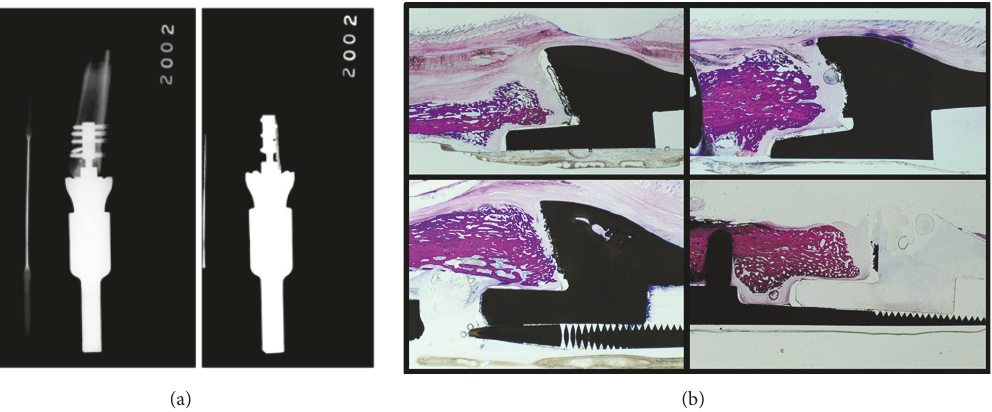
Figure 7: (a) This figure shows radiographs of the implant in Sheep 2B. (b) Histological analysis of Sheep 2B demonstrating tenuous osseointegration in the lower left hand quadrant but only bony encroachment toward the spindle base in the other three quadrants without fulminant